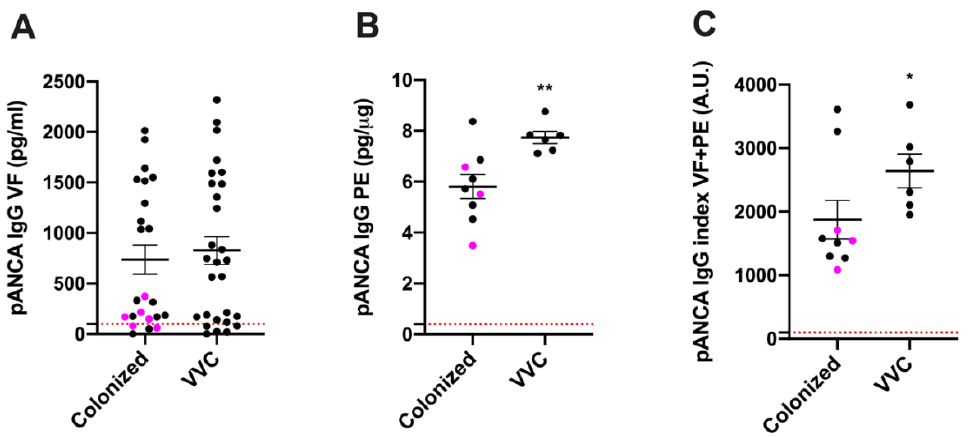
Figure 3. pANCA levels in VF and PE. ( A , B ) Mean ± SEM of pANCA IgG (pg / mL) in vaginal fluids (VF) and in protein extracts (pg / µ g) (PE). ( C ) pANCA IgG index in VF + PE expressed as arbitrary units (A.U.) from VVC and colonized women. The samples from women colonized by NAC species are colored in magenta. Levels of significance are indicated by ** p < 0.01 and * p = 0.0496.